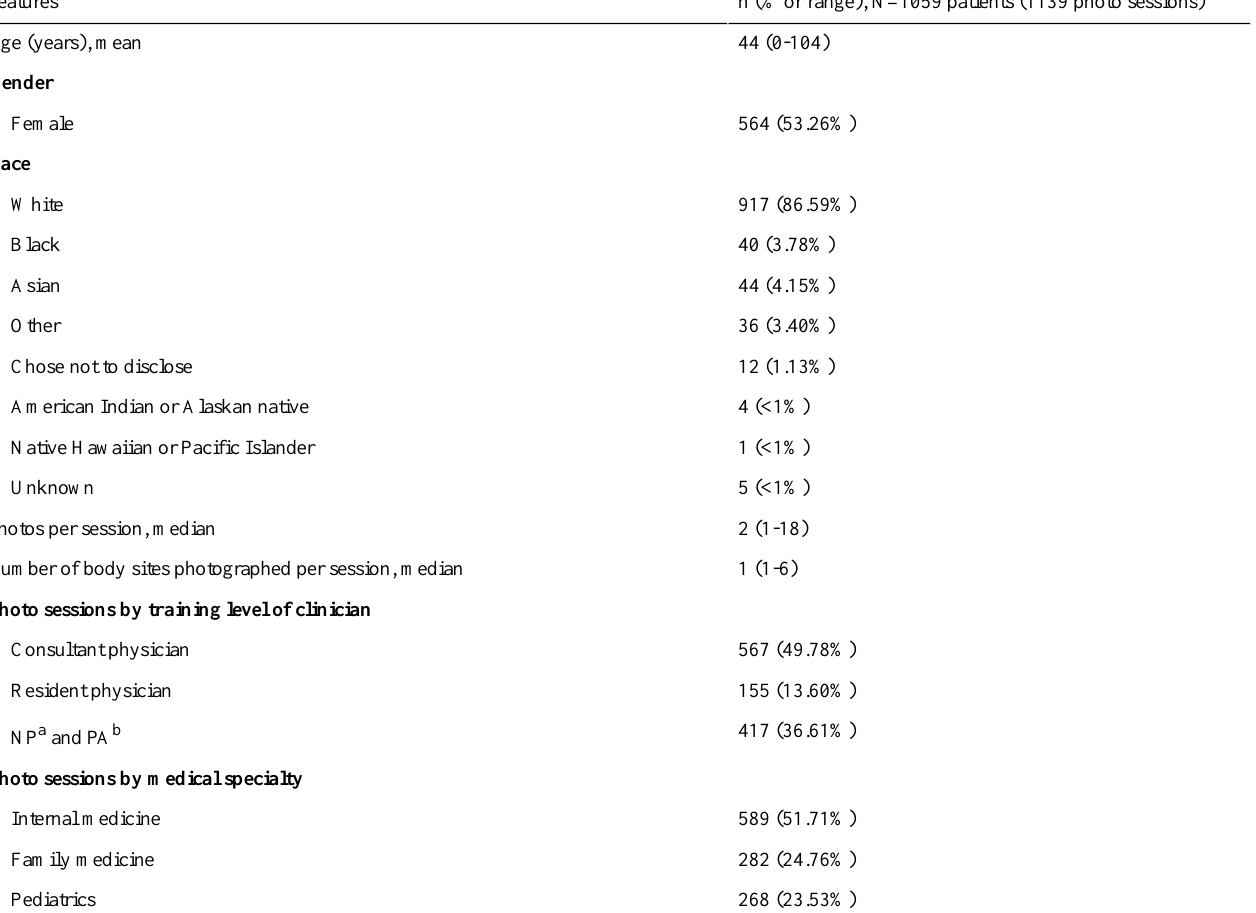
Table 1. Features of PhotoExam